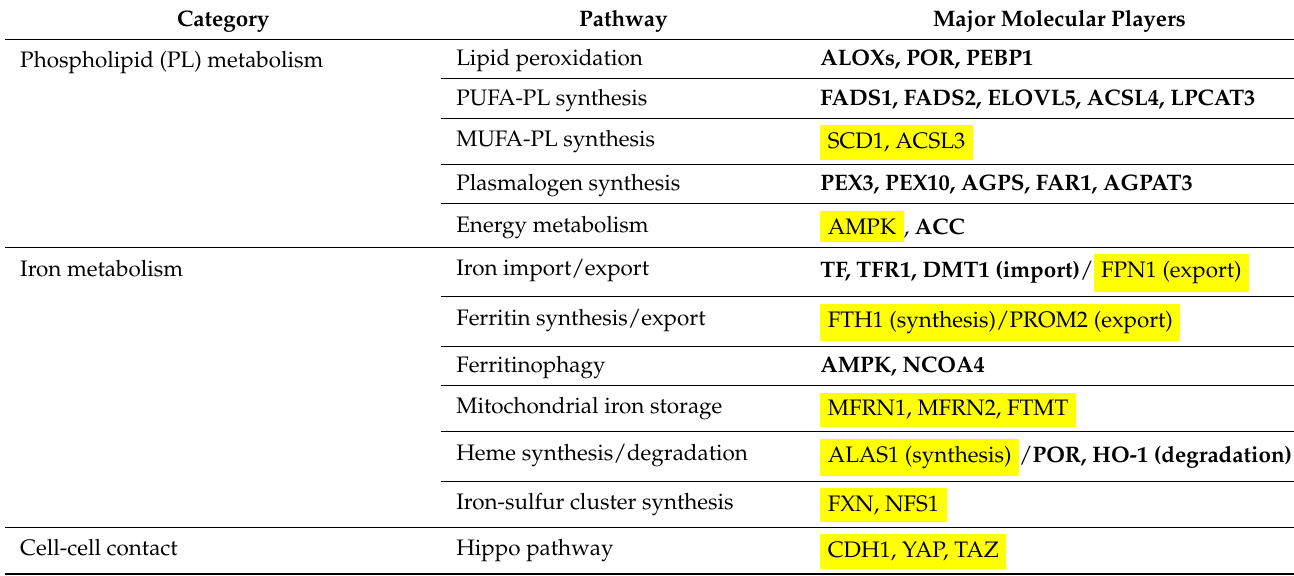
Table 1. Major players in ferroptosis regulation. Major ferroptosis-regulating molecules in each pathway are listed, with those that promote ferroptosis in bold and those that inhibit ferroptosis in yellow highlights . Abbreviations—PUFA, polyunsaturated fatty acid; MUFA, mono-unsaturated fatty